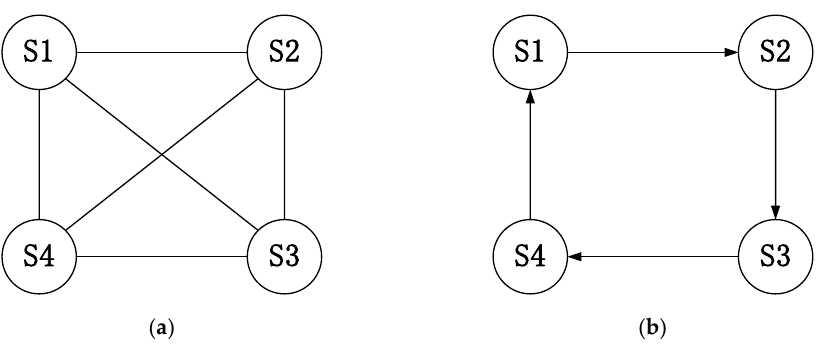
Figure 2. Communication graphs for SAR satellite formation. ( a ) The digraph graph; ( b ) the undirected graph.